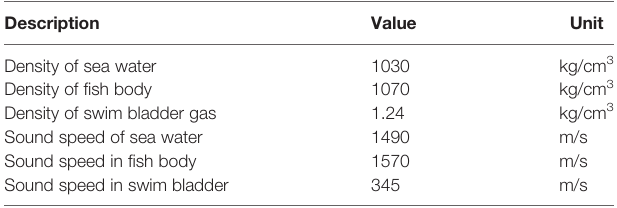
TABLE 1 | Acoustic parameters used in the KRM model of the TS of S. japonicus . Description